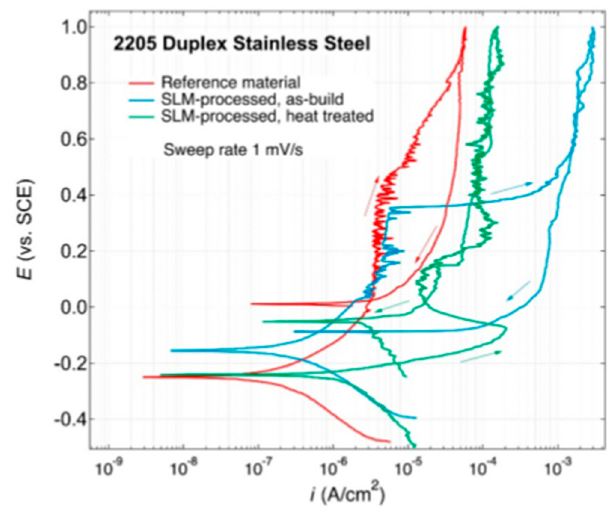
Figure 5. Cyclic potentiodynamic polarization (PDP) curves of the as-received cold-rolled/annealed reference alloy 2205, the as-SLM-processed duplex SS (DSS) 2205, and the SLM-processed DSS 2205 with heat treatment in a neutral 0.6 M NaCl solution at room temperature. The arrows indicate the polarization direction [47].